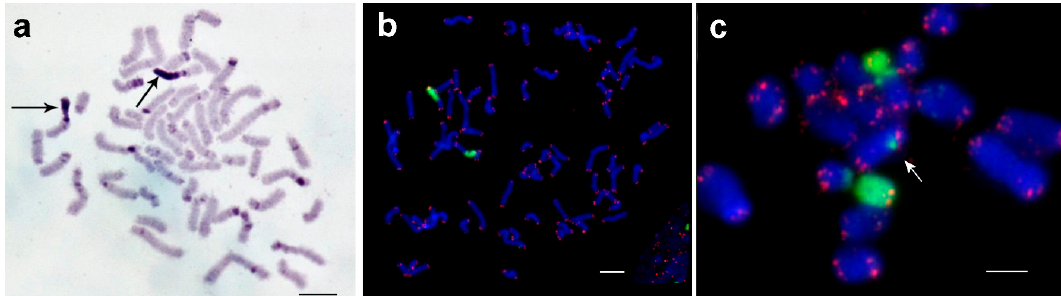
Figure 4. Metaphase plates of a female embryo of S. sipylus . ( a ) C-banding: large metacentrics contain large C-positive regions in one arm (arrows); ( b ) FISH as in Figure 1b; ( c ) FISH as in Figure 1b on a partial metaphase plate. Scale bar indicates 5 μ m.